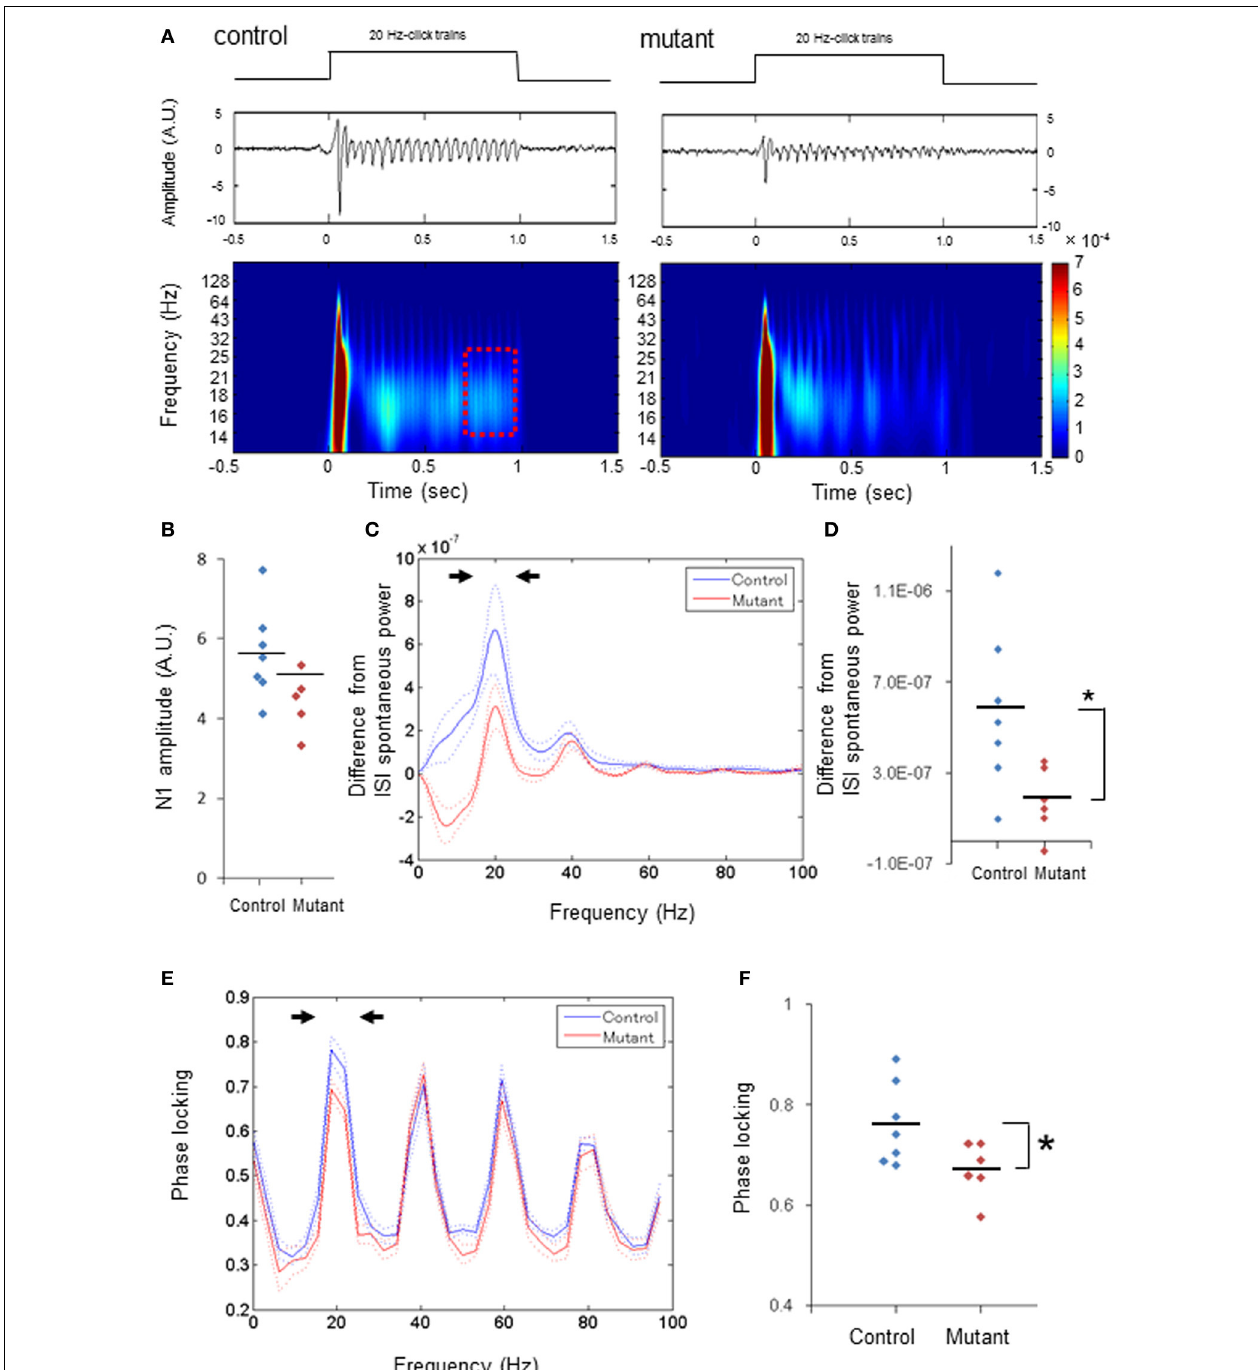
FIGURE 2 | Diminished power and phase-locking of 20-Hz ASSRs. (A) Representative examples of the averaged 20-Hz ASSR (middle, z-score) and spectrogram (bottom), in response to 20-Hz click trains (upper; 80dB intensity, 1000ms duration). Time 0 is tone onset. (B) No difference in the averaged N1 amplitudes (z-score) evoked by 20-Hz click trains between genotypes (blue for 7 fGluN1 control mice; red for 6 mutant mice). p = 0 . 54, unpaired Student’s t -test. (C) The mean difference (A.U.) from ISI spontaneous power in click train-evoked ASSR power during last 200ms before cessation of 20-Hz click trains (red